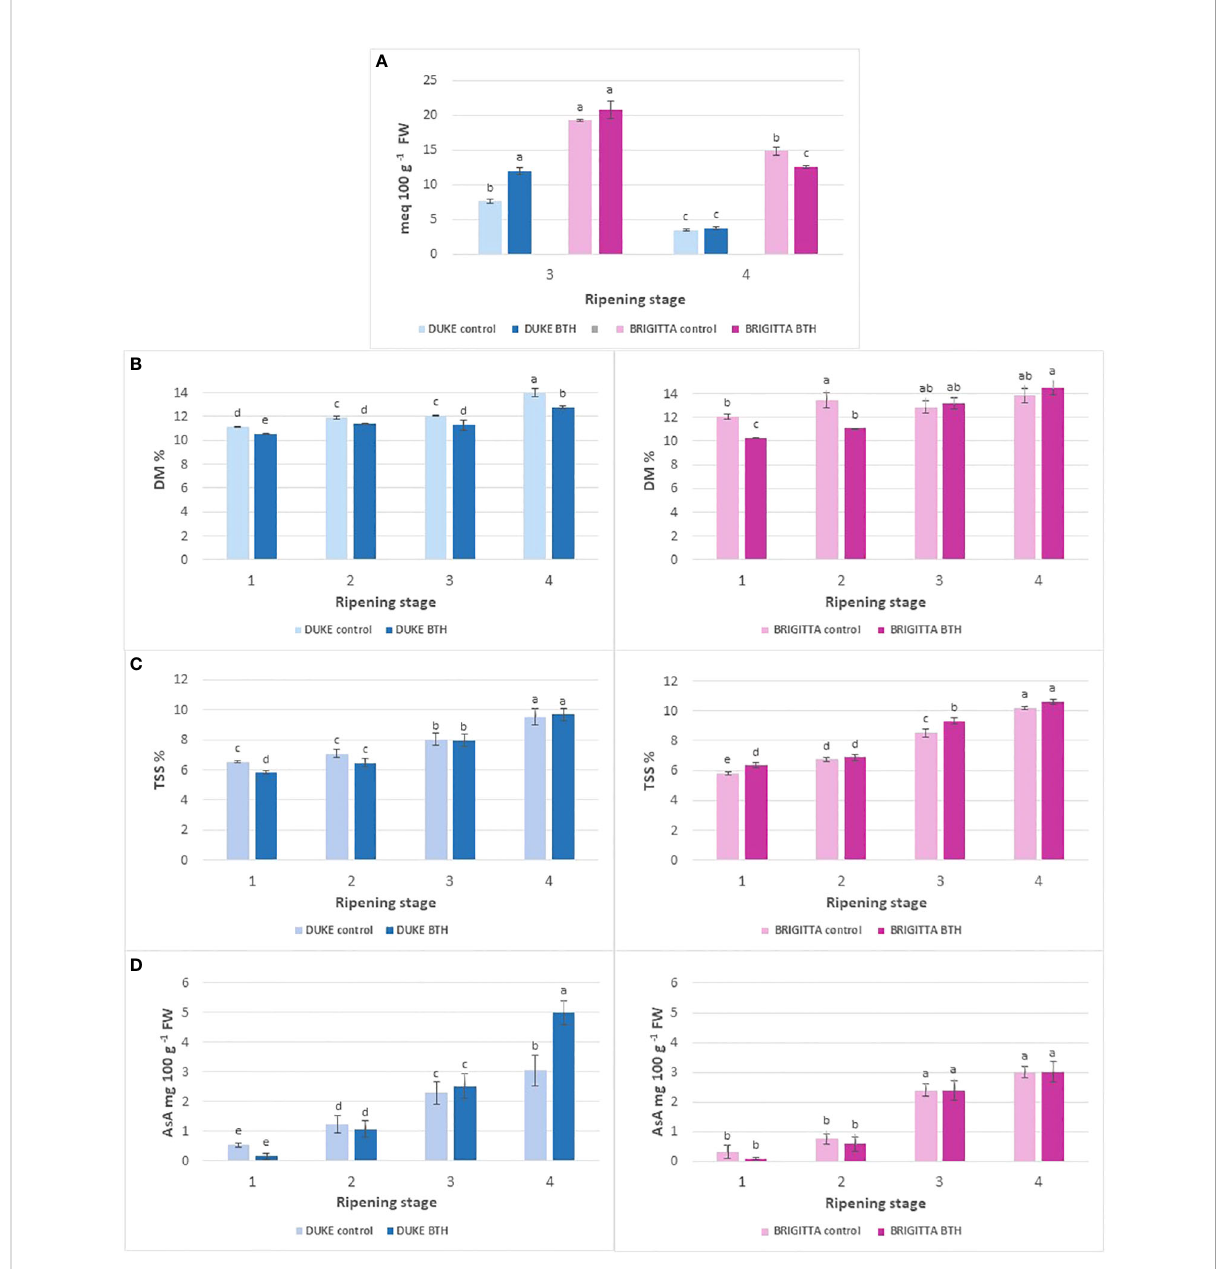
FIGURE 3 Effect of BTH treatment on (A) total titratable acidity and (B) dry matter, (C) total soluble solids and (D) ascorbic acid contents in cv ‘ Duke ’ (left) and ‘ Brigitta ’ (right). Values represent means ± SE (n = 6). Different letters indicate statistical differences (p ≤ 0.05) among ripening classes and between treatments, for each